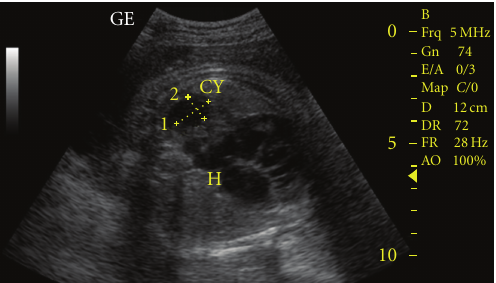
Figure 2: Sonographic examination of congenital cystic lung lesion after thoracocentesis.